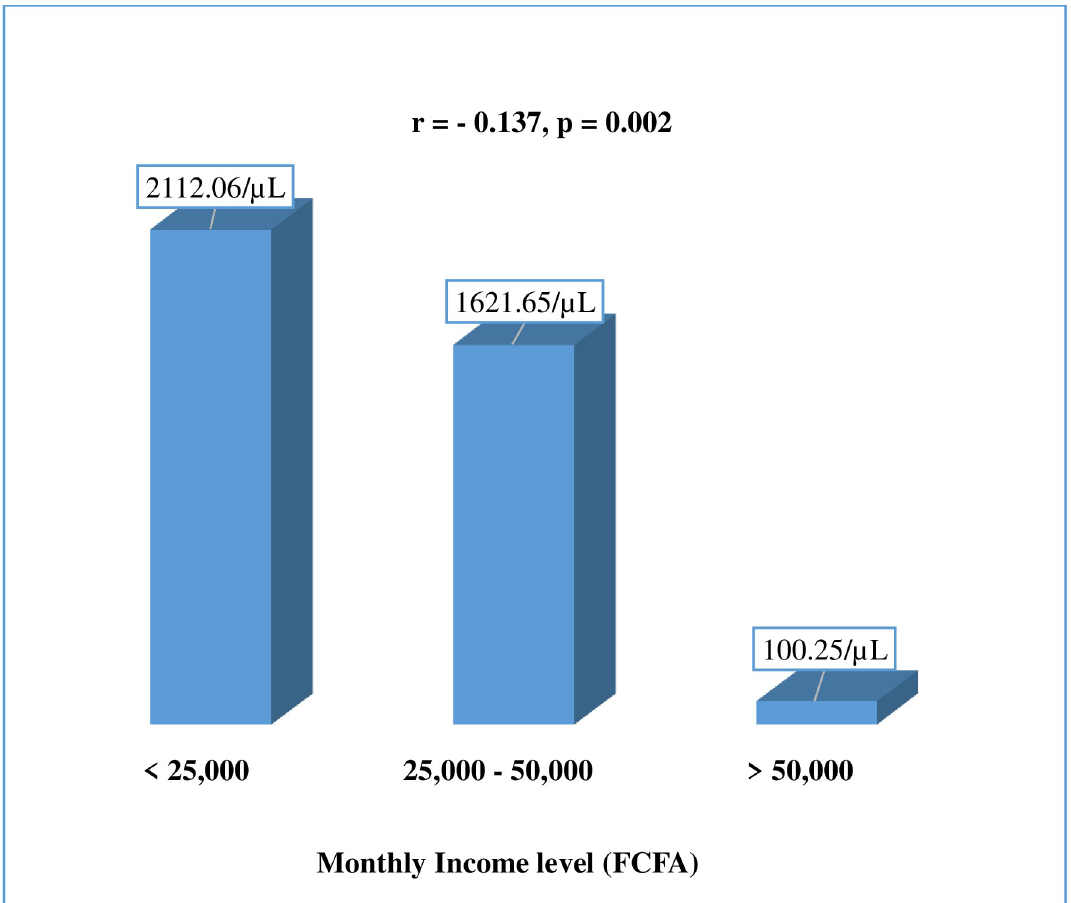
Fig 6. Relationship between mean parasite density of malaria and income